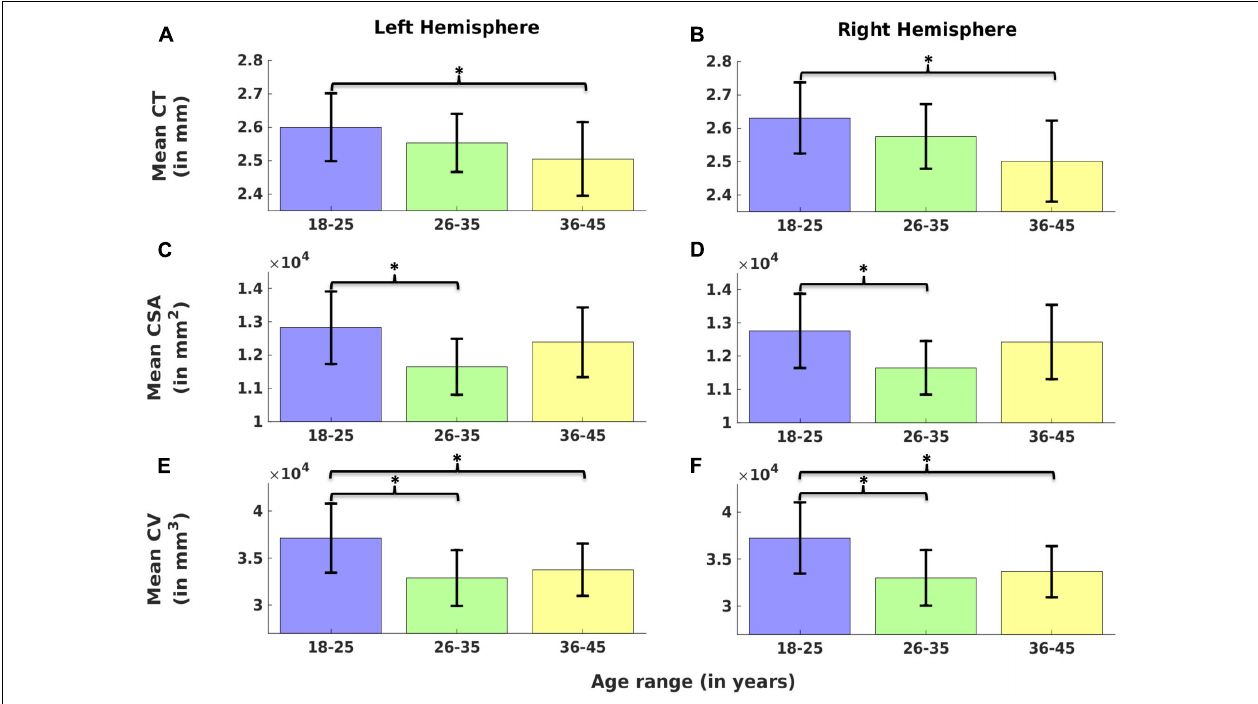
FIGURE 2 | Comparison of cortical measures (Cortical thickness: CT, cortical surface area: CSA, and cortical volume: CV) across age groups. Mean CT (A,B) , mean CSA (C,D) and mean CV (E,F) over left (A,C,E) and right hemisphere (B,D,F) are plotted across three age groups (G1: 18–25, G2: 26–35, and G3: 36–45). Error bars represent the standard deviation. Significant differences are denoted by ∗ (one-way ANOVA, p < 0.05, corrected for multiple comparisons).